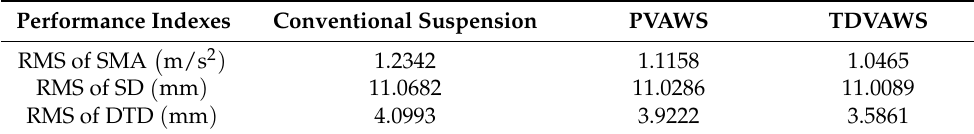
Table 6. RMS of vehicle performance indexes under random excitation. Performance